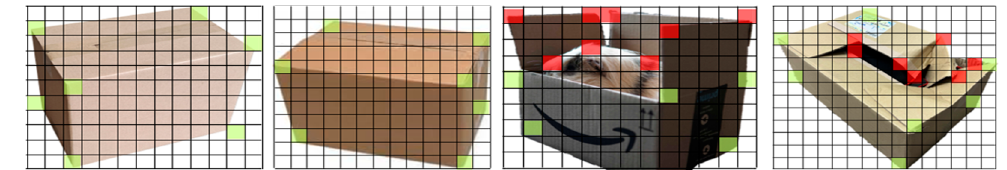
Figure 8. Image recognition and classification of the parcel boxes.